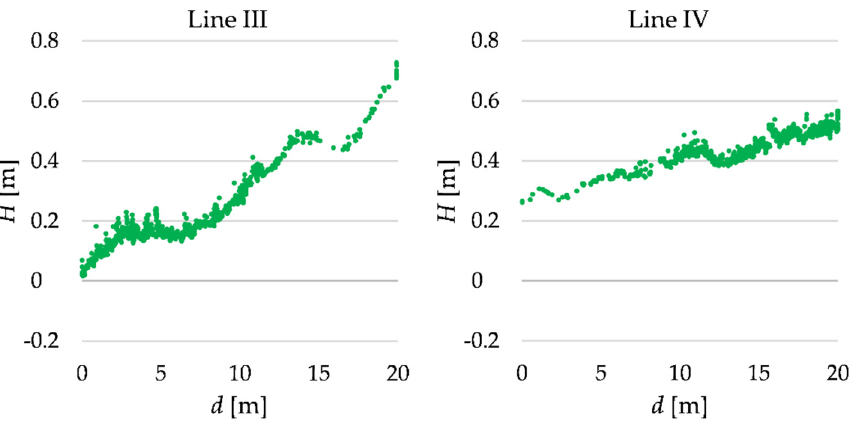
Figure 11. TLS data related to lines III and